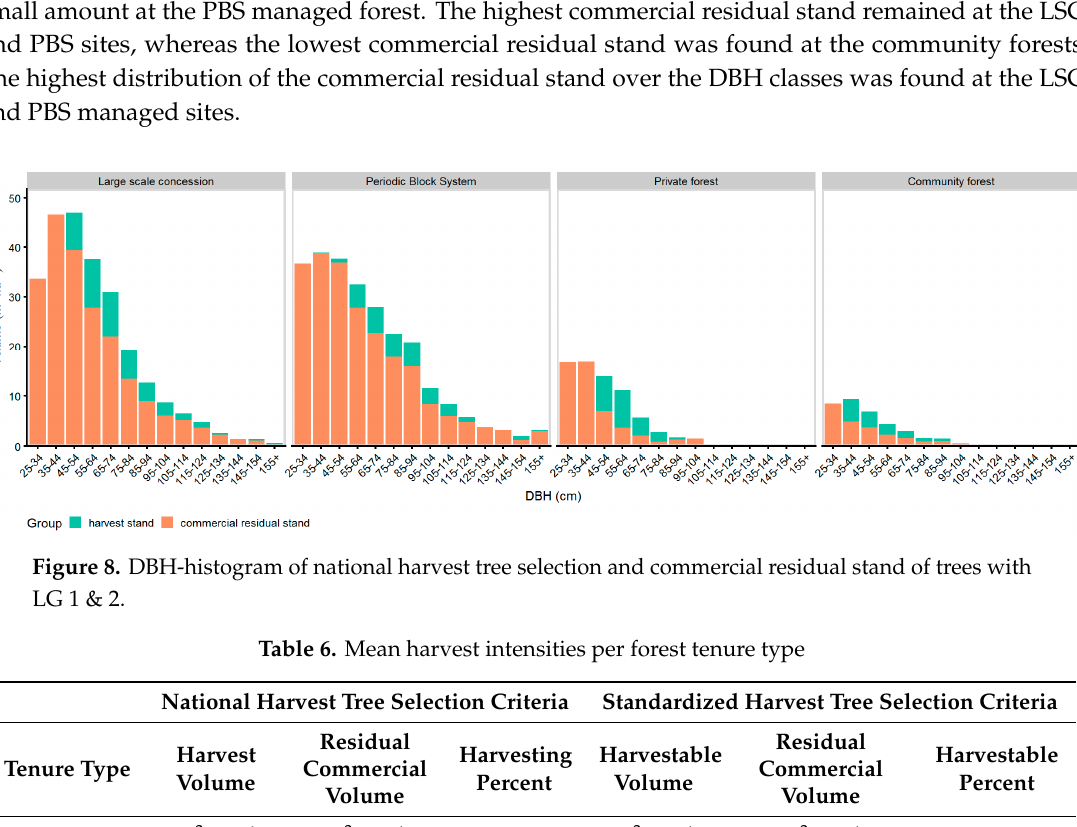
Table 6. Mean harvest intensities per forest tenure type National Harvest Tree Selection Criteria Standardized Harvest Tree Selection Criteria